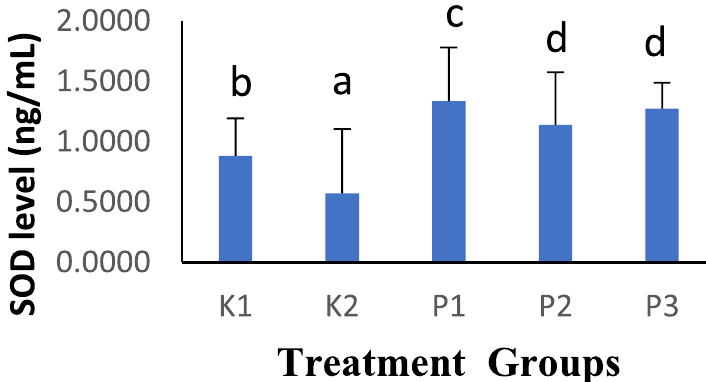
Figure 2. Graph changes of SOD levels (ng/mL) before and after treatment RDF extract. Note: The different notation letters on the bar graph are significantly different